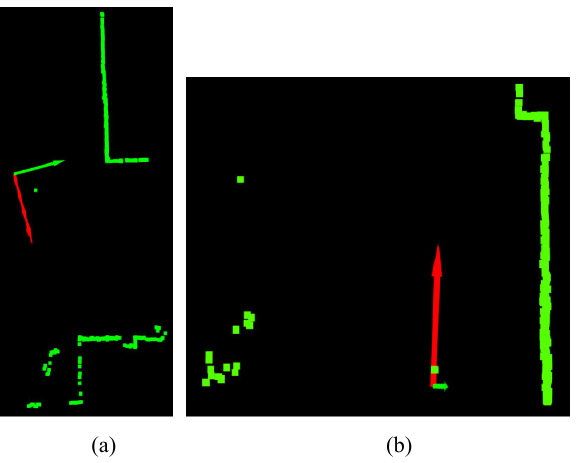
Fig. 6 Eigenvector of the covariance matrix. The red arrow and green arrow mean the eigenvector, and the length of the arrow is the correspond eigenvalue: (a) eigenvecotor of normal environment and (b) eigenvector of corridor